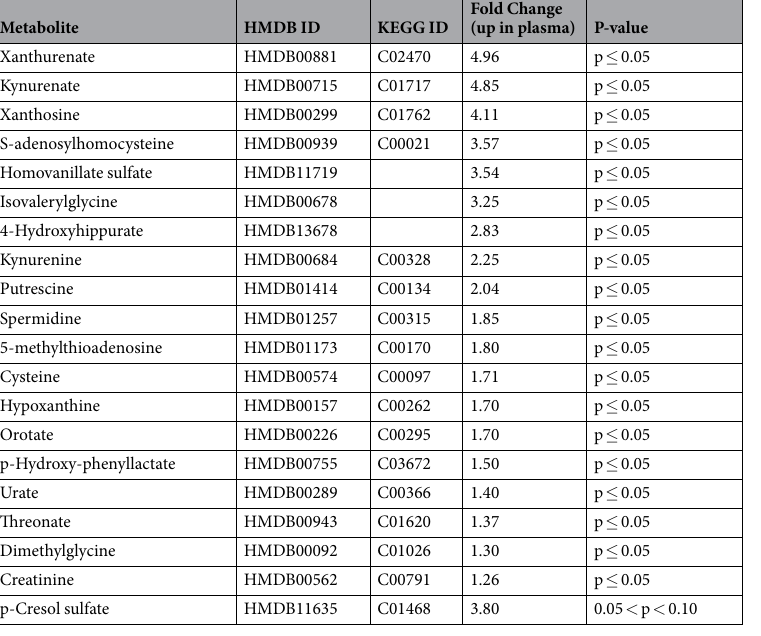
Table 2. Uremic Toxins/Retention Solutes Accumulating in the Plasma of Chemical Double Knockout ( Oat3KO Treated with Probenecid versus Untreated Oat3KO ). Fold Change in plasma concentration of uremic toxins/retention solutes [( Oat3KO + probenecid) vs ( Oat3KO untreated